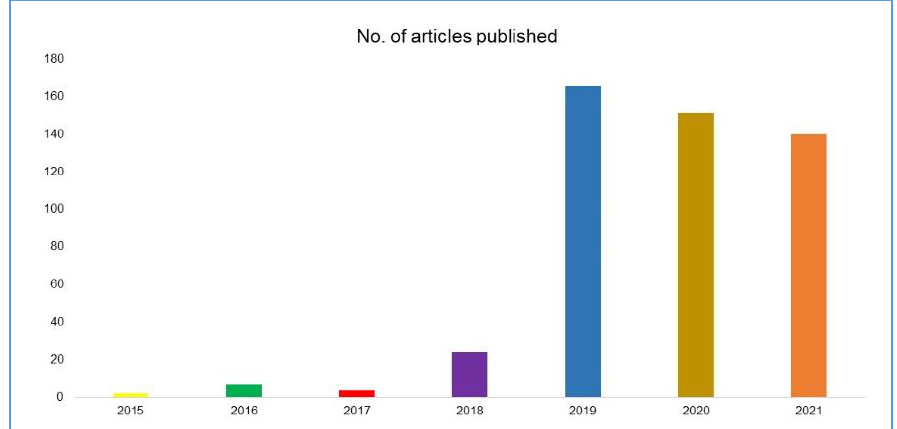
Figure 2. Number of articles published per year.